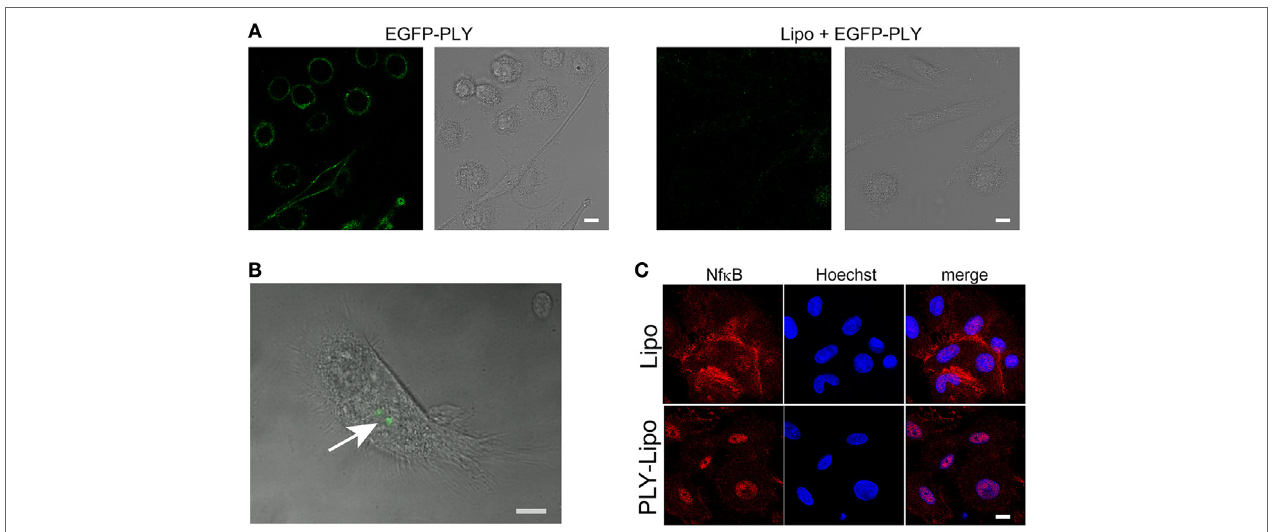
FigUre 2 | Human macrophages sense pneumolysin (PLY)-bearing liposomes. (a) PLY does not bind to macrophages in the presence of cholesterol:sphingomyelin liposomes. Day 7 M-CSF differentiated macrophages, either pre-incubated with liposomes (Lipo) or left untreated, were stimulated with 4 µg/ml EGFP-PLY and serial confocal imaging was performed. Images from T = 2 min post PLY additions are shown. The toxin binds exclusively to untreated macrophages. (B) Uptake of sequestered PLY on liposomes by human macrophages in vitro (arrow). Human primary macrophages were stimulated with EGFP-PLY-liposomes and analyzed at T = 4 h by confocal microscopy for intracellular EGFP-PLY (bar 10 µm). (c) Stimulation of macrophages with PLY-Lipo induces NfkB translocation from the cytoplasm into the nucleus. Day 7 M-CSF differentiated macrophages were stimulated with PLY-Lipo for 4 h. Afterward, cells were fixed, permeabilized, and stained with a monoclonal antibody against NfkB (red) and Hoechst (chromatin,